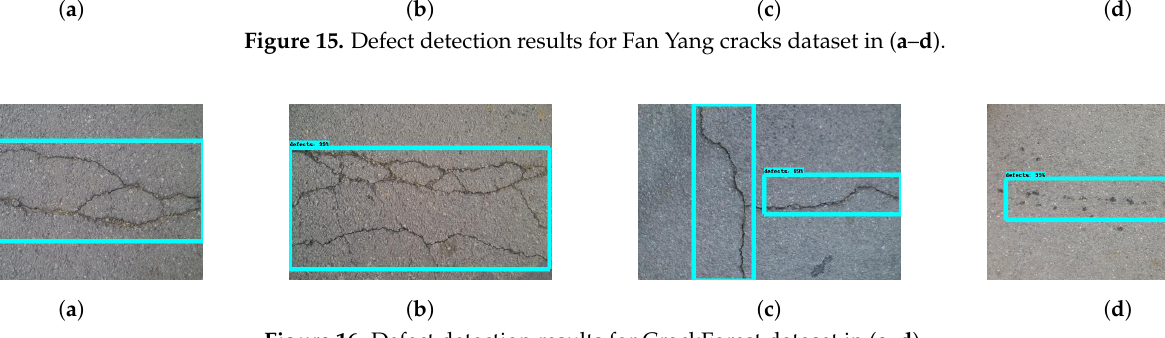
Figure 16. Defect detection results for CrackForest dataset in ( a – d